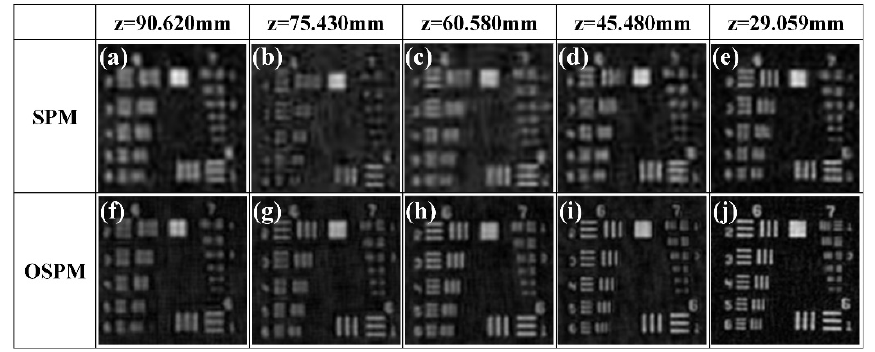
Figure 4. Reconstructed enlarged amplitude images using ( a – e ) the conventional SPM and ( f – j ) proposed OSPM at different recording distances z.